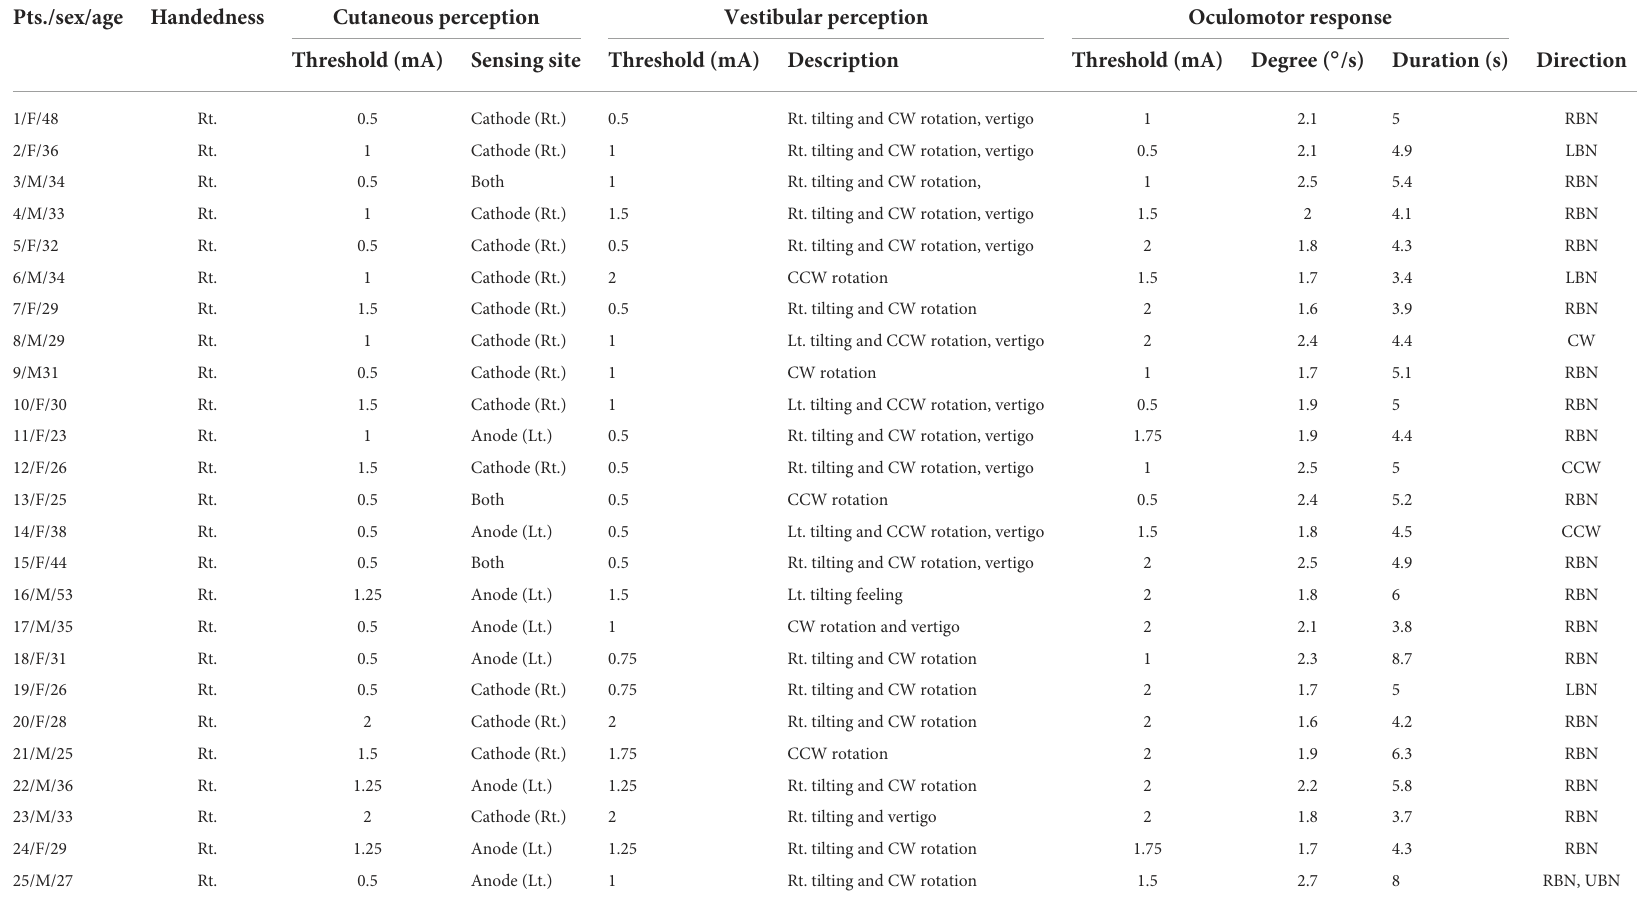
TABLE 1 Thresholds for somatosensory and vestibular perception and oculomotor response and their characteristics in response to GVS with the cathode on the right and the anode on the left (CRAL).